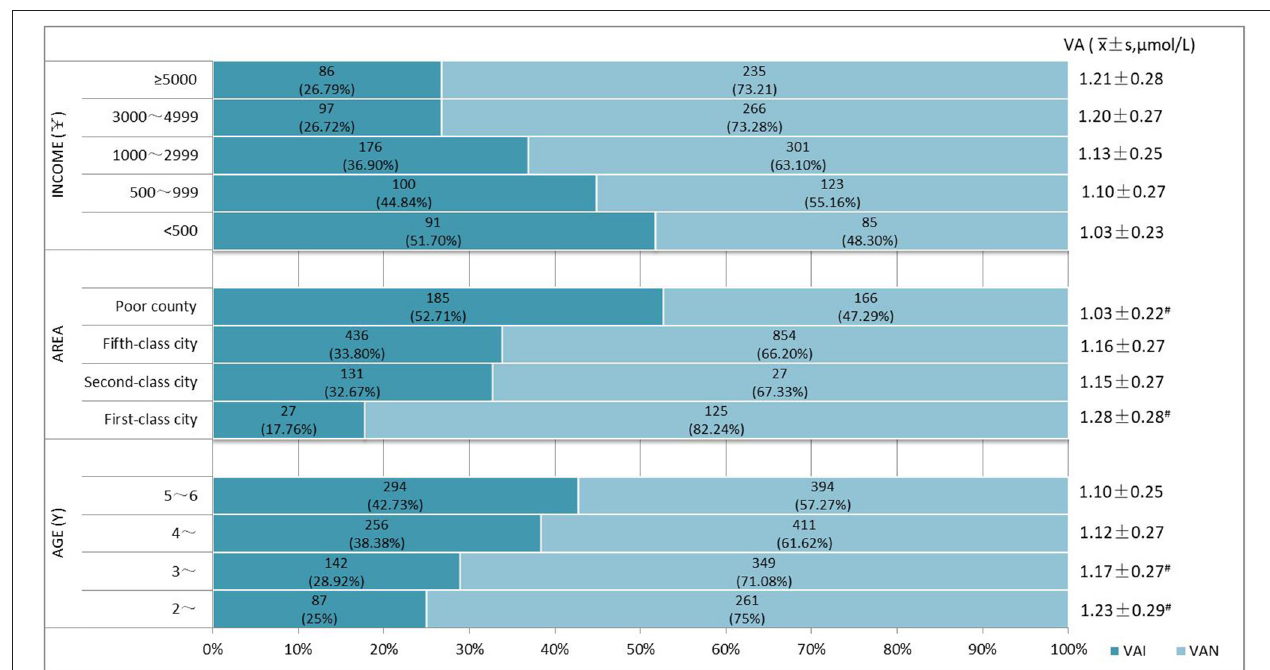
FIGURE 2 | Vitamin A levels and prevalence of vitamin A insufficiency (VAI) in different groups. VAD, vitamin A deficiency, serum retinol < 0.70 µ mol /L; MVAD, marginal vitamin A deficiency, 0.70 µ mol /L ≤ serum retinol < 1.05 µ mol /L; VAN, normal vitamin A, serum retinol ≥ 1.05 µ mol/L; # Significant difference in vitamin A levels and prevalence of VAD and MVAD between groups ( p < 0.05).